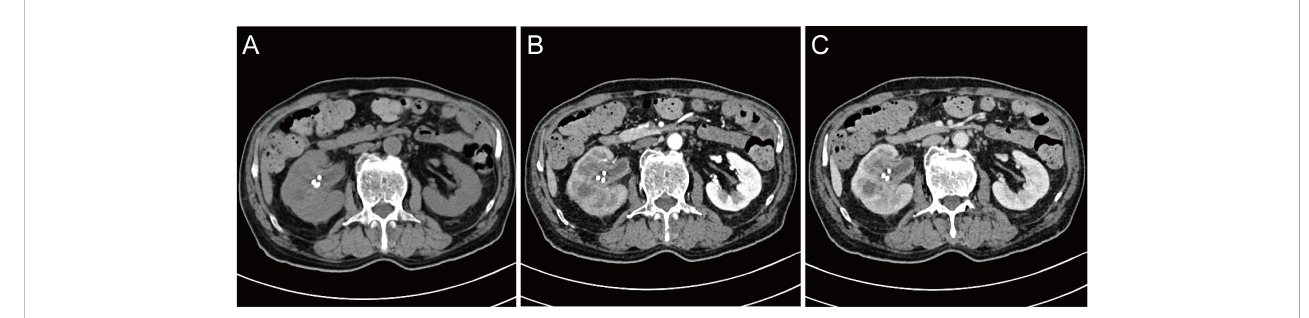
FIGURE 2 Review of enhanced CT after nephrostomy. (A) plain scan; (B) arterial phase; (C) venous